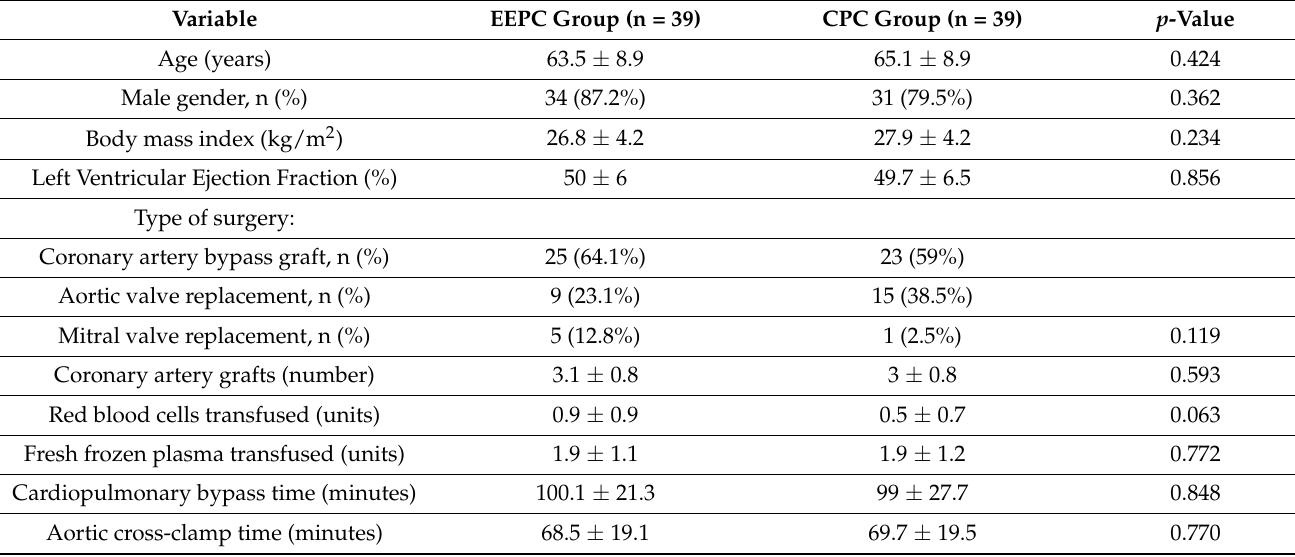
Table 1. Baseline demographic and clinical characteristics of study